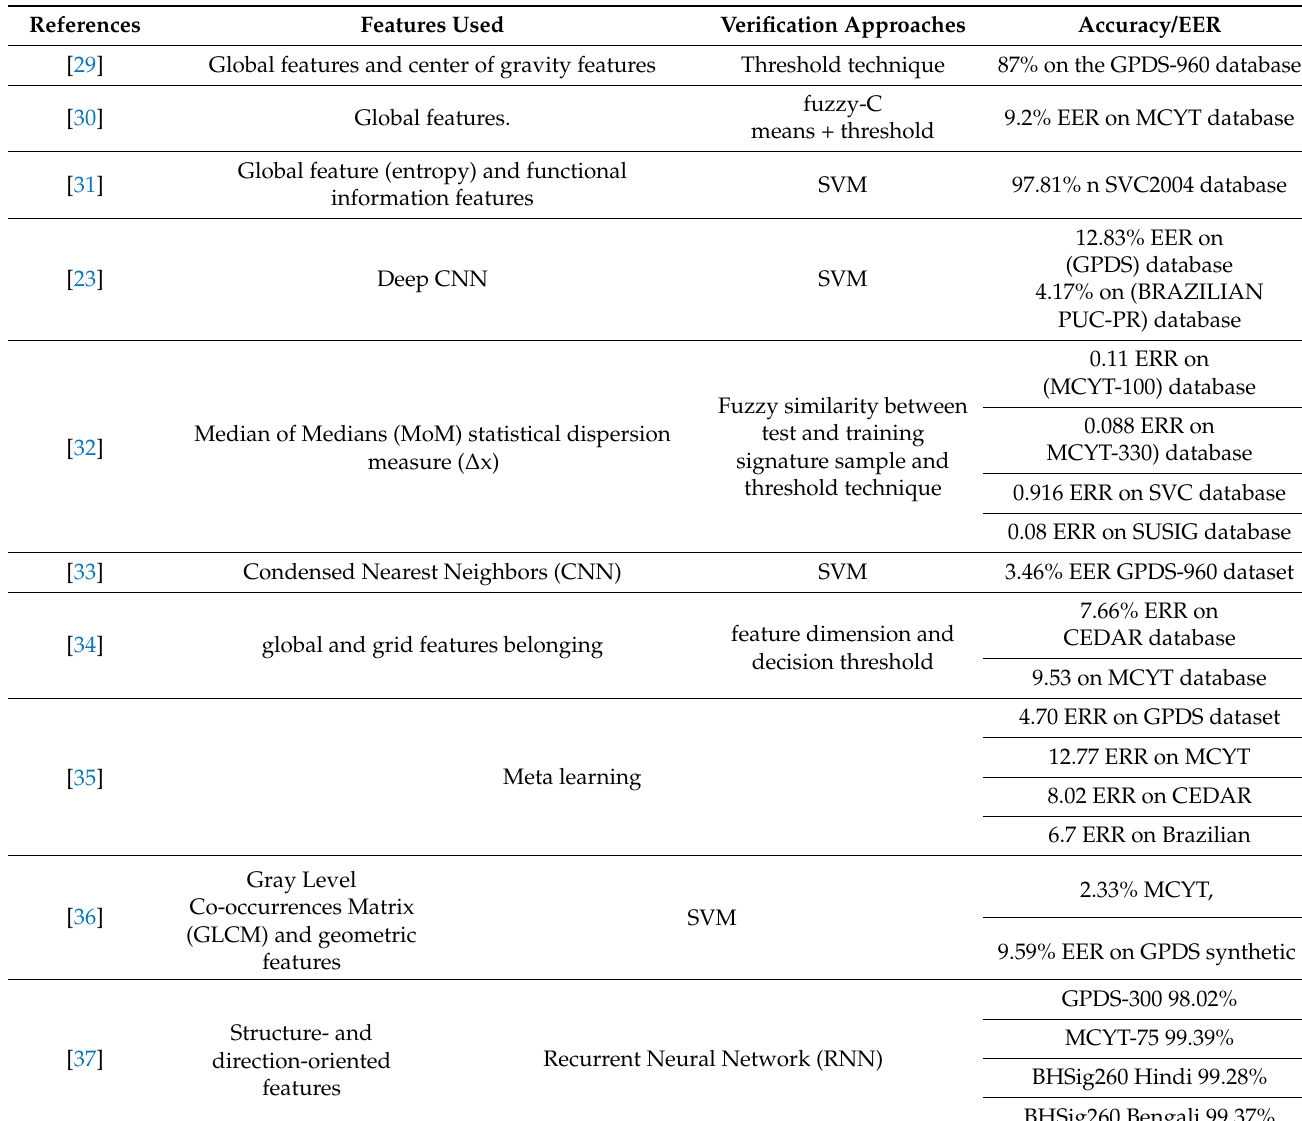
Table 1. Summary of related